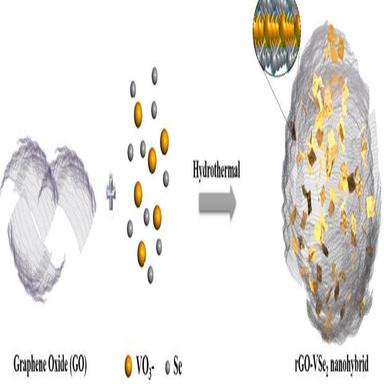
Schematic representation for the synthesis of rGO-VSe2 nanohybrid.